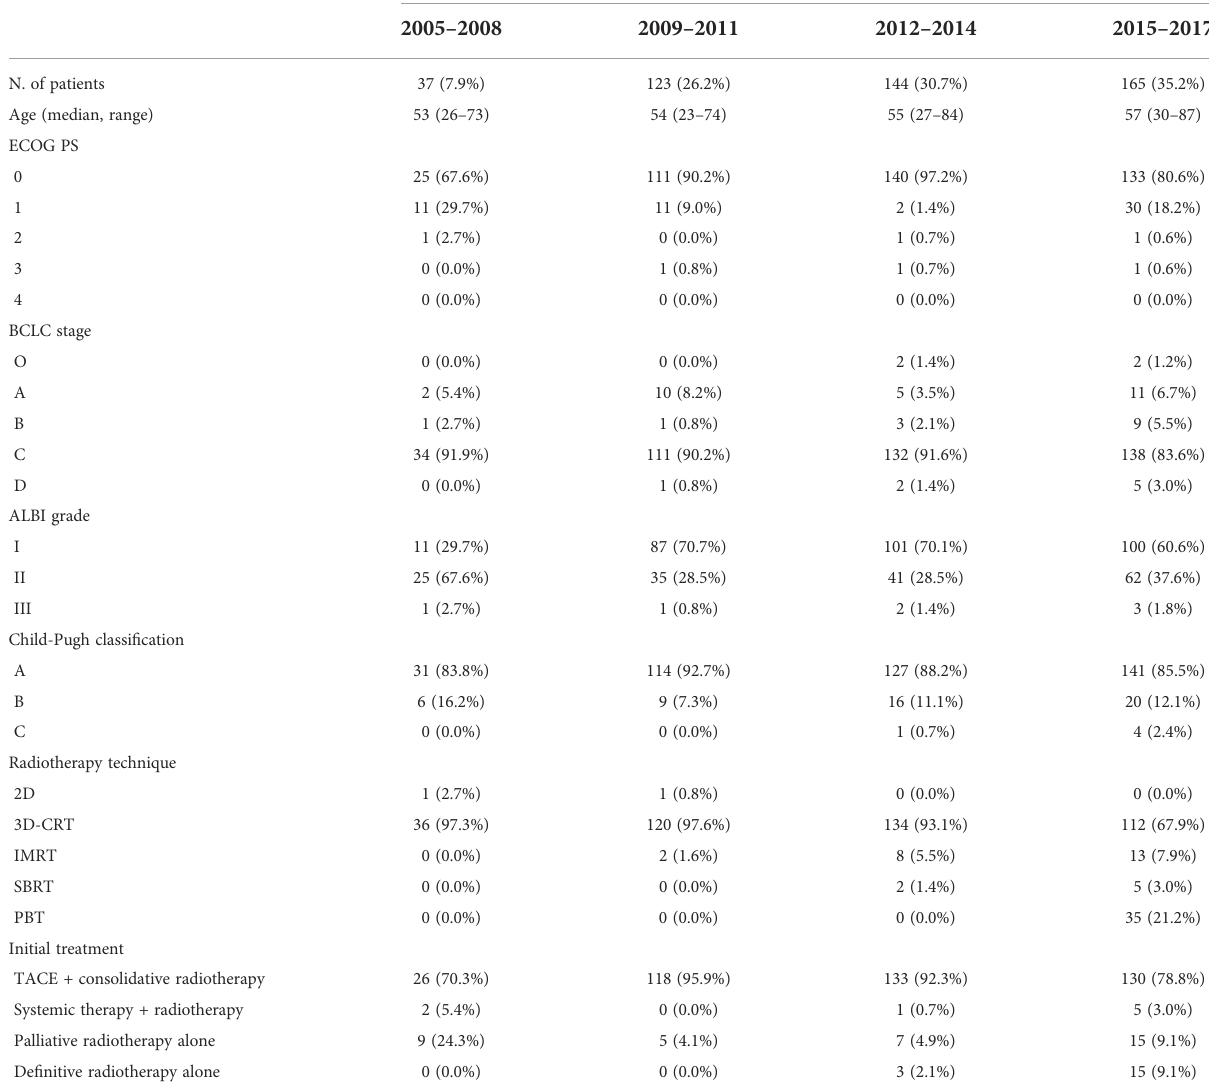
TABLE 1 Characteristics of patients who received radiotherapy as initial management for intrahepatic